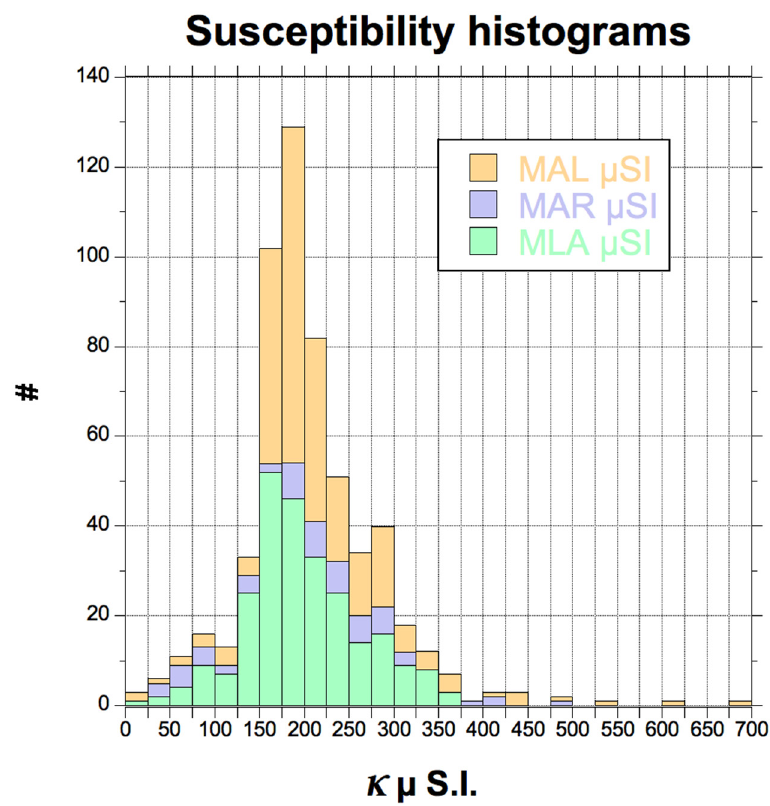
Figure 2. Susceptibility histograms of site means from previously published AMS studies (data by Gleizes et al. [34] for MLA; Leblanc et al. [44] for MAL; Antolín et al. [46], for MAR, partially reprocessed by Porquet et al. [44]). Table 1. Main statistical variables from previous studies in Maladeta (MAL), Marimanha (MAR) and the Mont-Louis Andorra (MAL) granites (based on data by Leblanc et al., 1994 [45]; Antolín- Tomás et al. [46] and Gleizes et al. [34] respectively). O.S: Outcropping Surface, S. km 2 ; sites per sq.